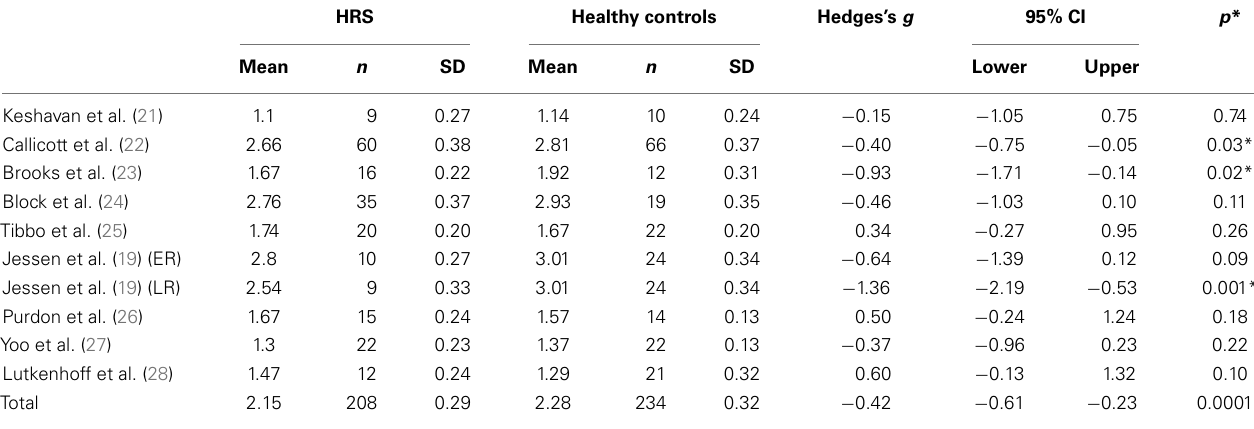
Table 2 | Effect size of studies investigating NAA/Cr in high-risk subjects for schizophrenia and healthy